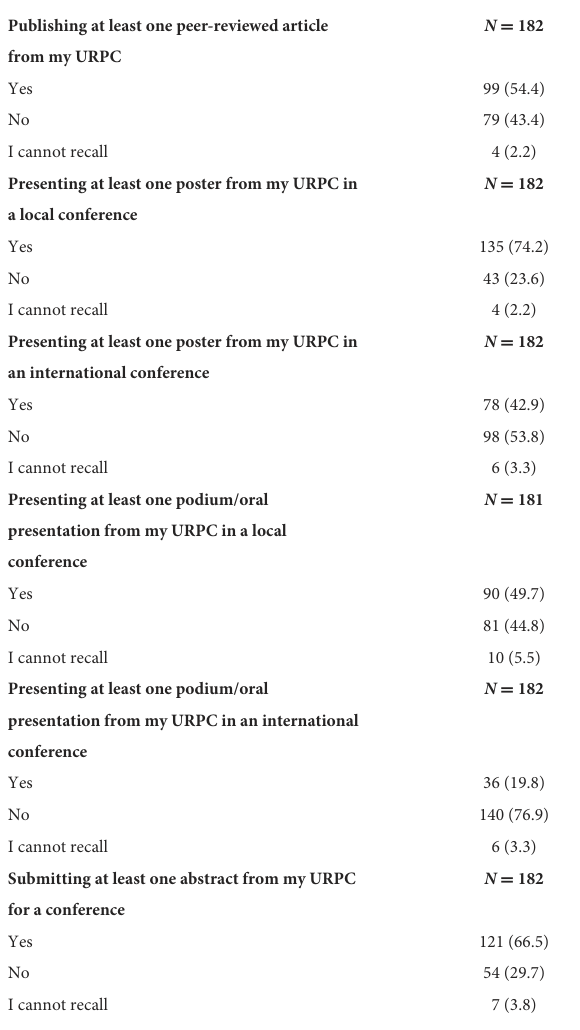
TABLE 4 Participants’ reported outcomes after taking the undergraduate research in pharmacy courses